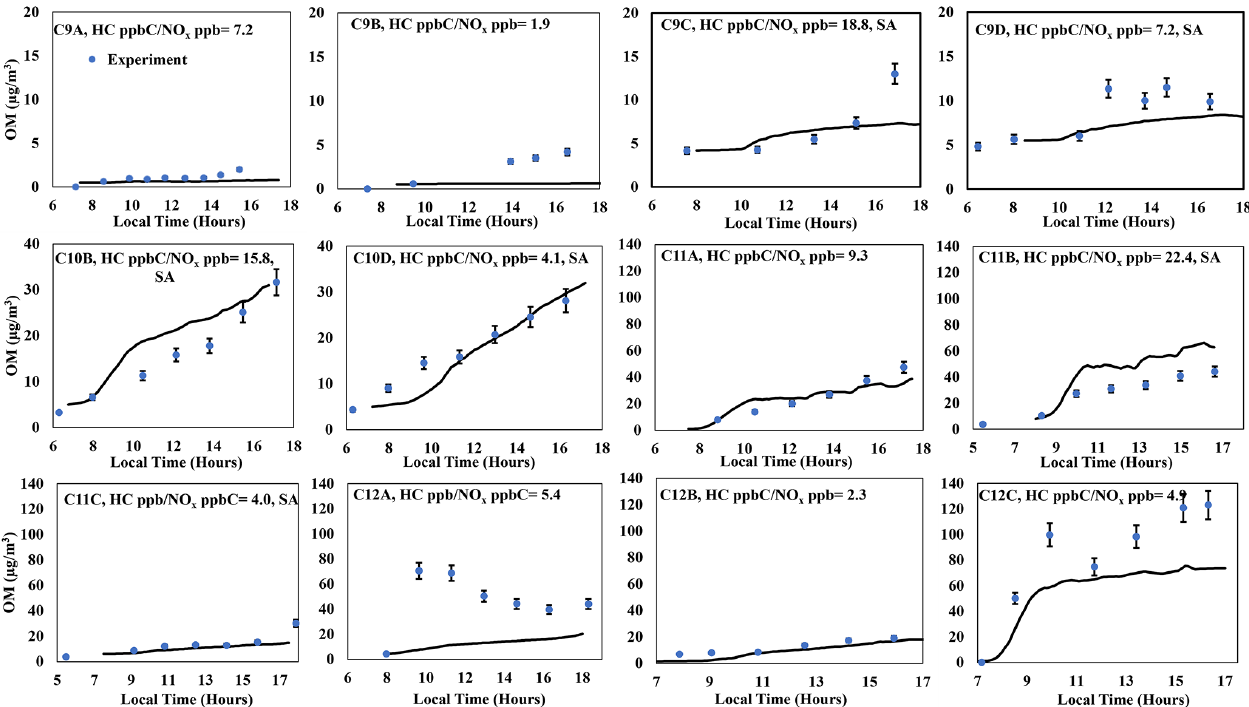
Figure 3. Simulated SOA mass for alkanes C9, C10, and C12 using a product distribution derived from the MCMs with alkyl peroxy radical autoxidation reactions added. The blue dots represent observed SOA data that are corrected for particle wall loss to the chamber. Error bars represent 9% uncertainty associated with the OC/EC measurement and particle wall loss